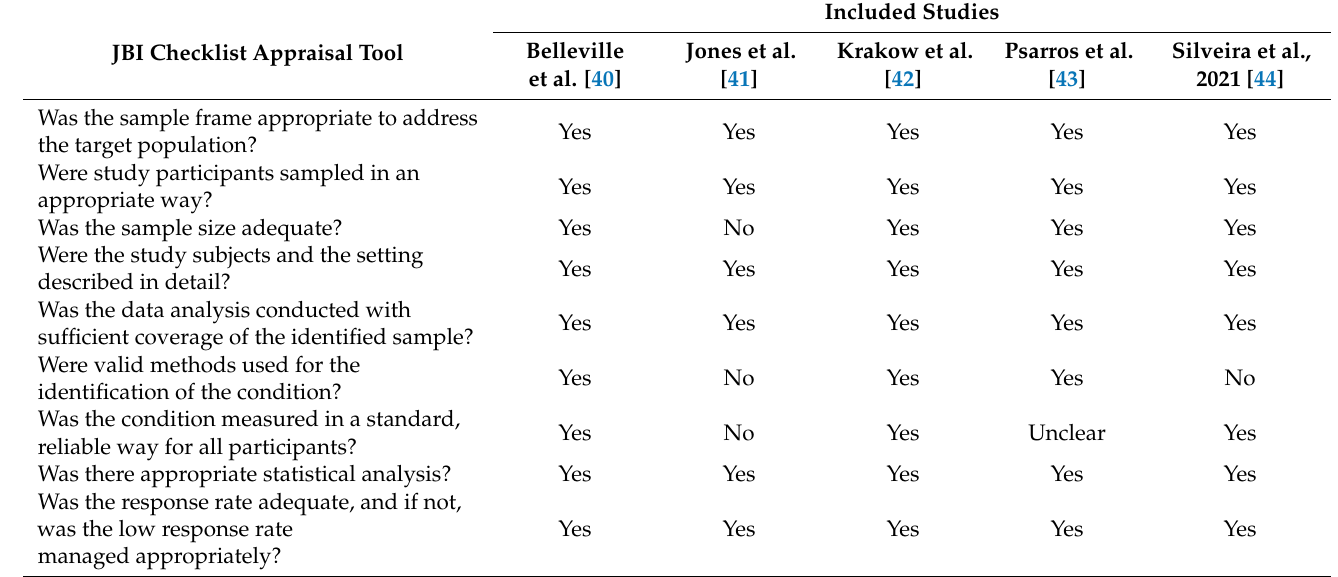
Table 3. Risk of bias